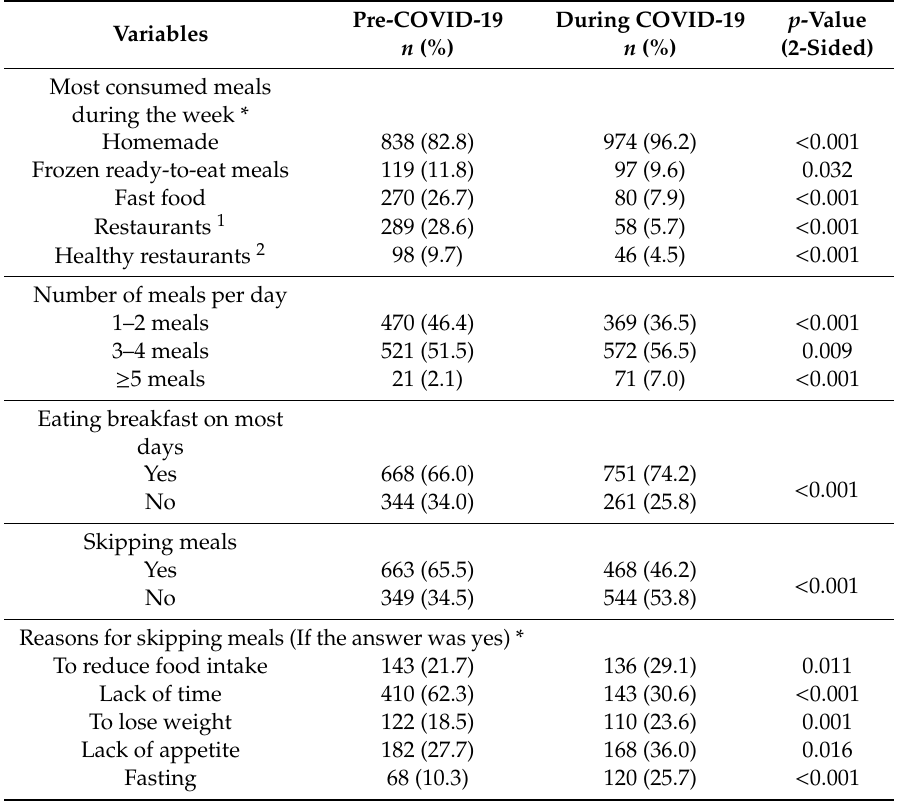
Table 3. Eating habits pre- and during COVID-19 pandemic ( n =